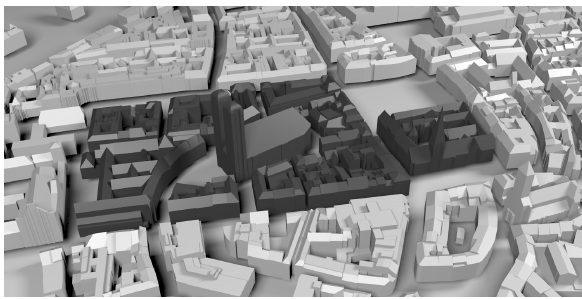
Figure 10: Test area in Munich. The darker area is indicating the test area used for the performance tests. This is the area